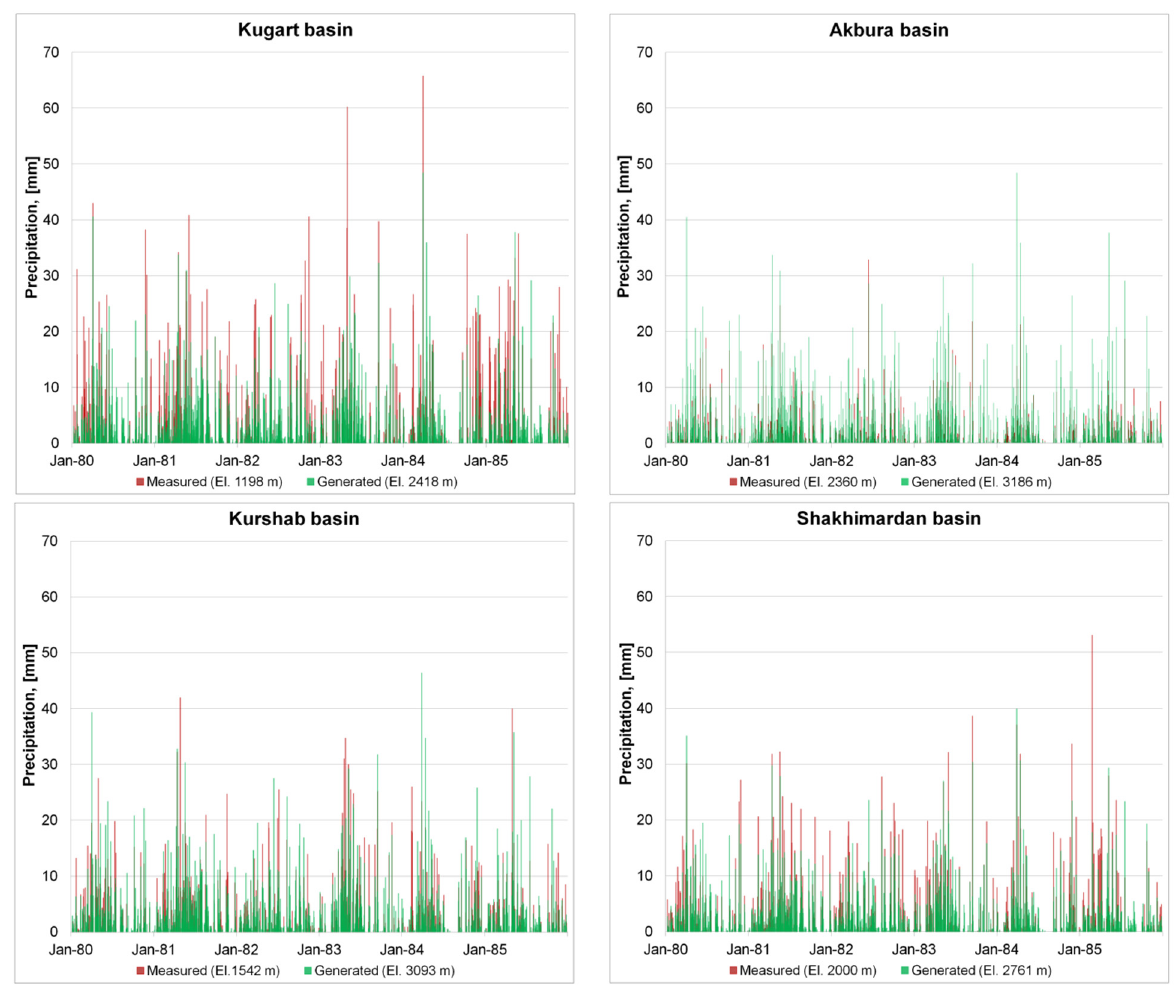
Figure 7. Time series plots of allocated precipitation to the centroids and measured precipitation at neighboring weather stations of the four river